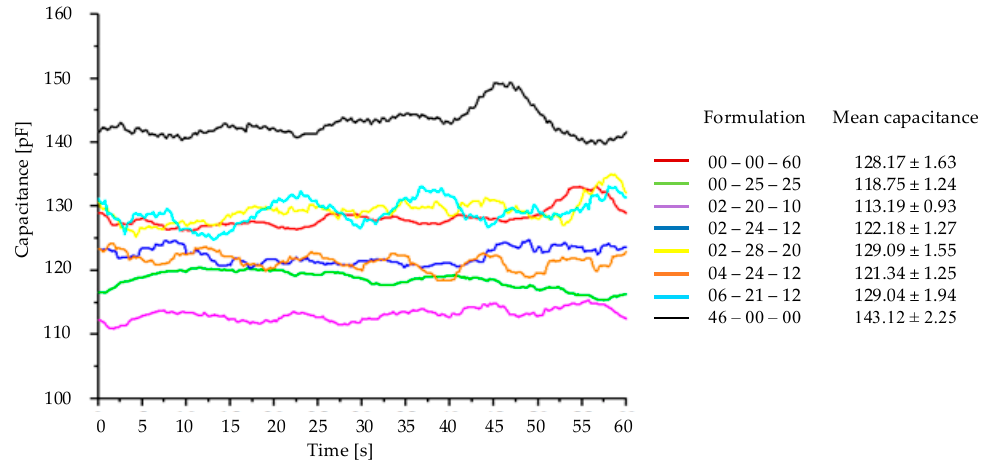
Figure 8. Mobile mean of 20 samples with the overflow dosing mechanism. Table 4. Mobile mean of each fertilizer formulation, standard deviation and respective moisture content.